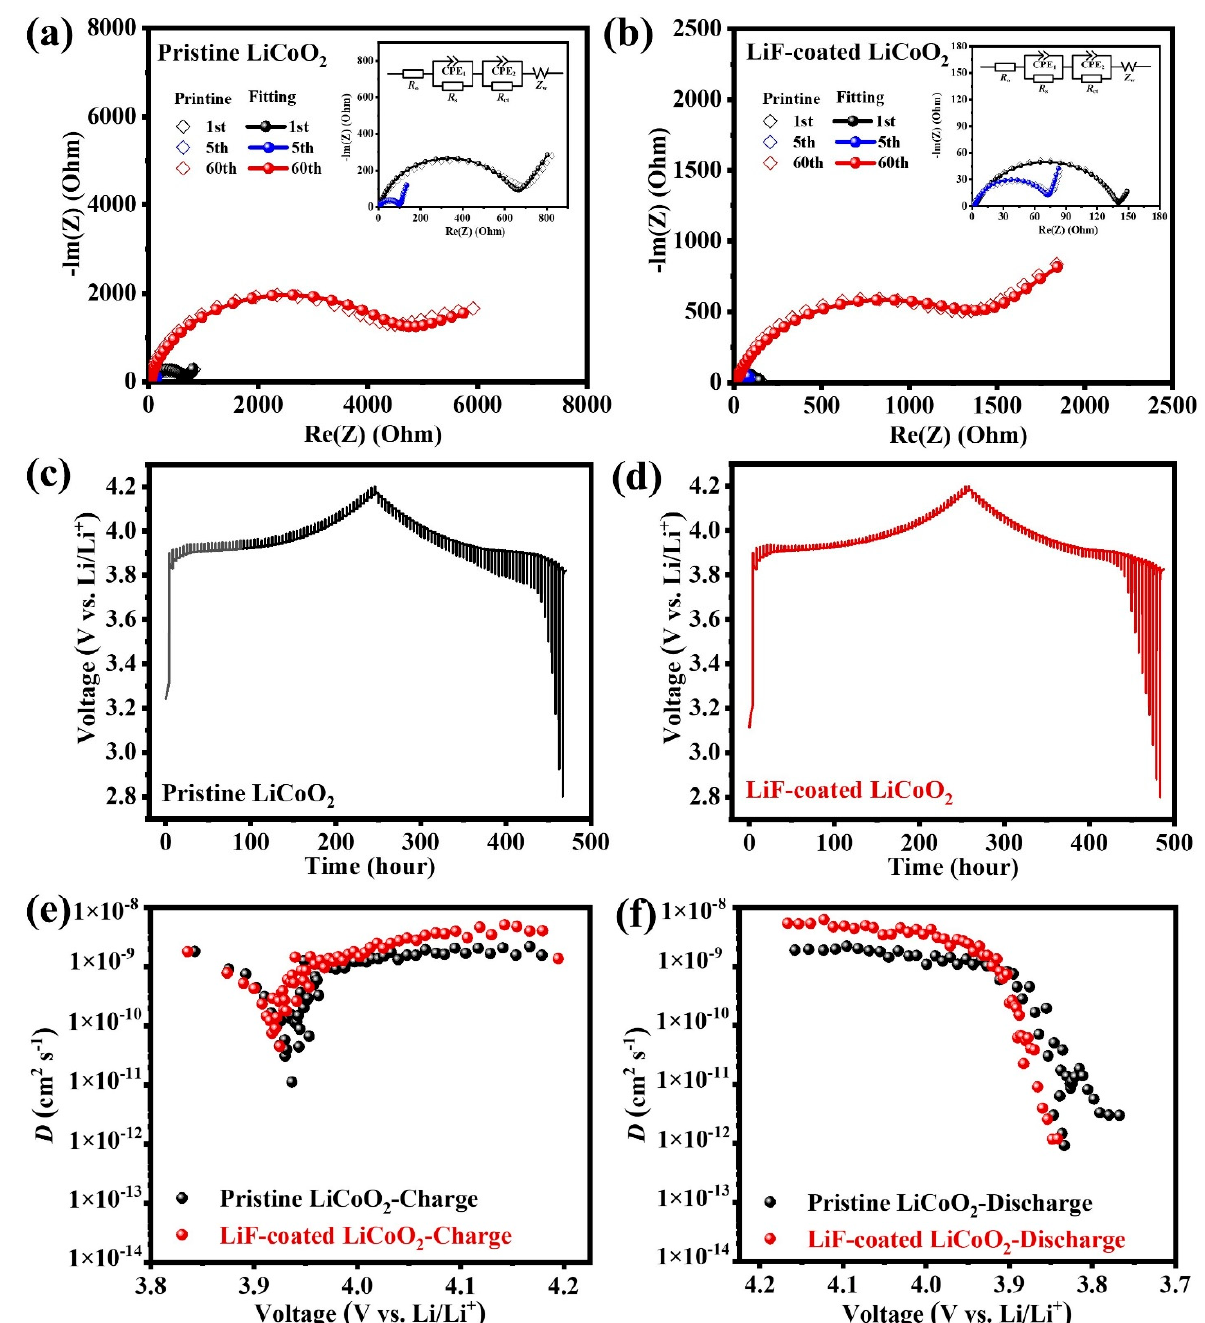
Figure 4. Electrochemical impedance spectrum of ( a ) pristine LCO and ( b ) LiF-coated LCO after the 1st, 5th, and 60th cycles. ( c , d ) Galvanostatic intermittent titration curves and ( e , f ) corresponding Li-ion diffusion coefficients of pristine LCO and LiF-coated LCO.